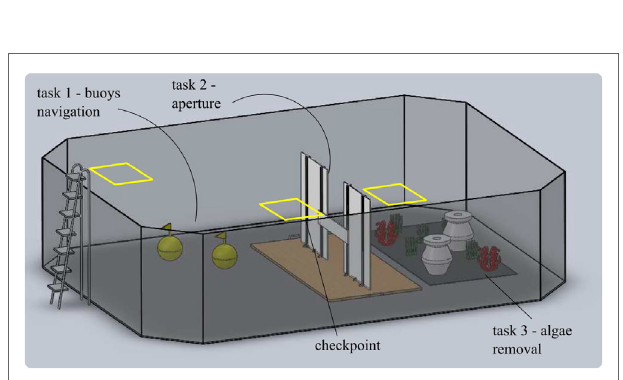
FIGURe 4 | the underwater race was made of three tasks, and checkpoints were positioned at the surface of the water .